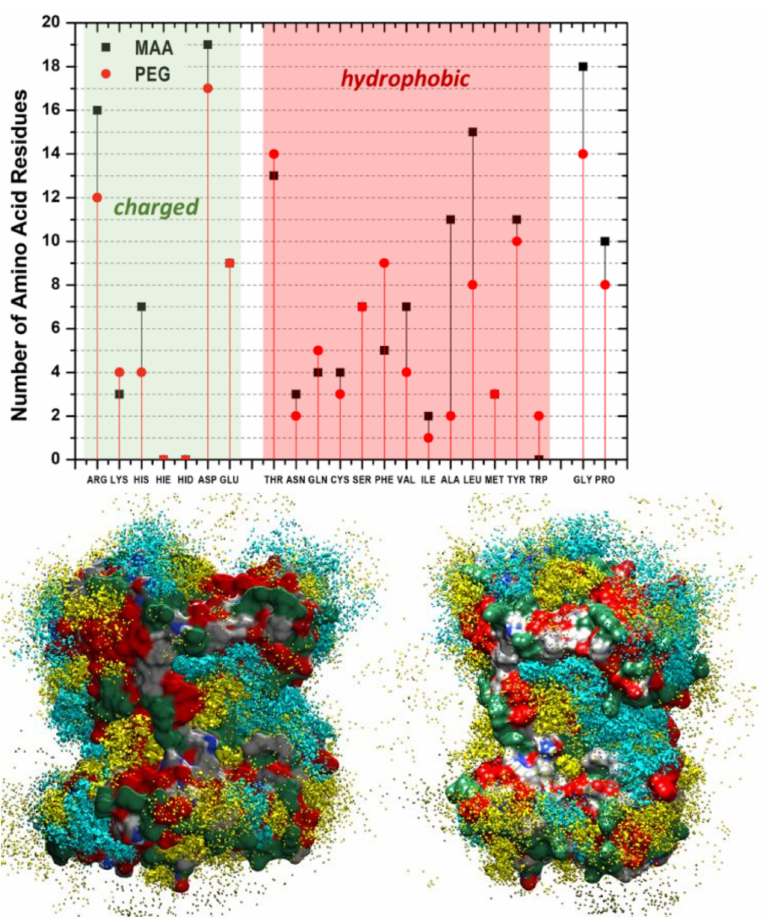
Figure 4. (Upper panel) number of amino acids within 3.5 Å of the adsorbed monomers; (lower panel) SDF (spatial distribution functions) of the MAA and PEG monomers around the MMP9 protein at X concentration with water molecules (undisplayed). MAA yellow and PEG cyan. Contour plots at 0.5 a.u. Red and green regions on the MMP9 surface indicate hydrophobic and charged zones,